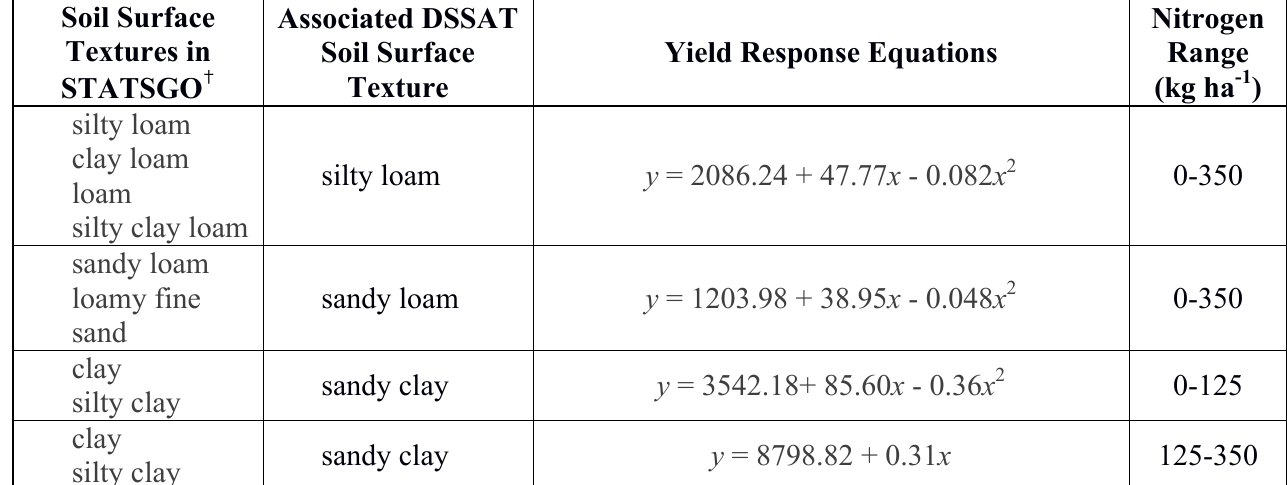
Table S1 Yield response to nitrogen curves by soil type calculated from DSSAT CERES-Maize output. In the yield response equations, y is yield and x is nitrogen application rate. All equations were significant at P < 0.05